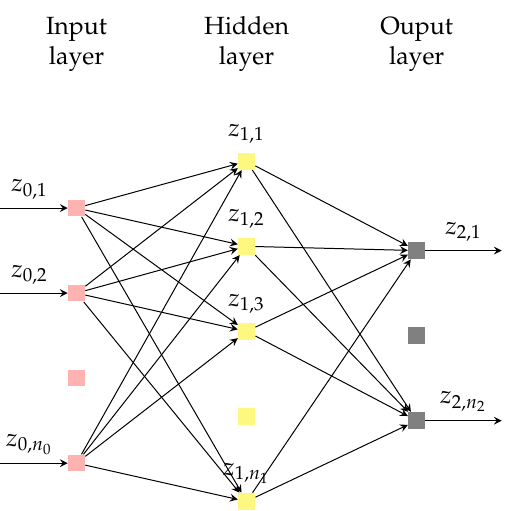
Figure 1. A feed-forward Neural Network with one hidden